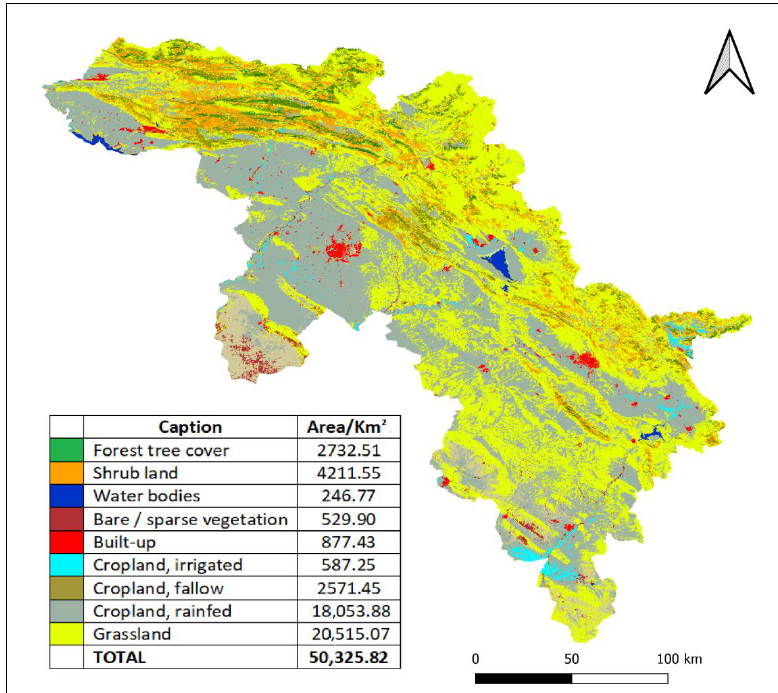
Figure A1. Land use and land cover classes in the KRI. Water 2022 , 14 , x FOR PEER REVIEW